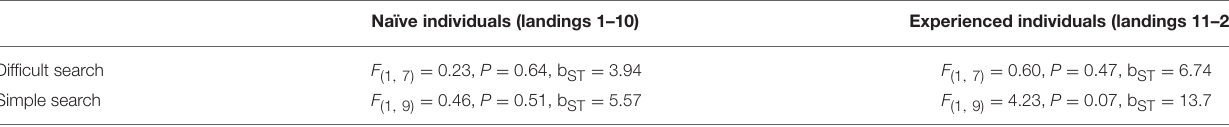
circles—second 10landings inthe same searchingsequence).Butterflies searchedin either adifficultsearching environment, where ared-coloredhost wasinterspersed amongstahigh densityoffournon-hosttypes,ora simple search environmentwhere agreen-coloredhostwasinterspersedin alow densityofonenon-hosttype.